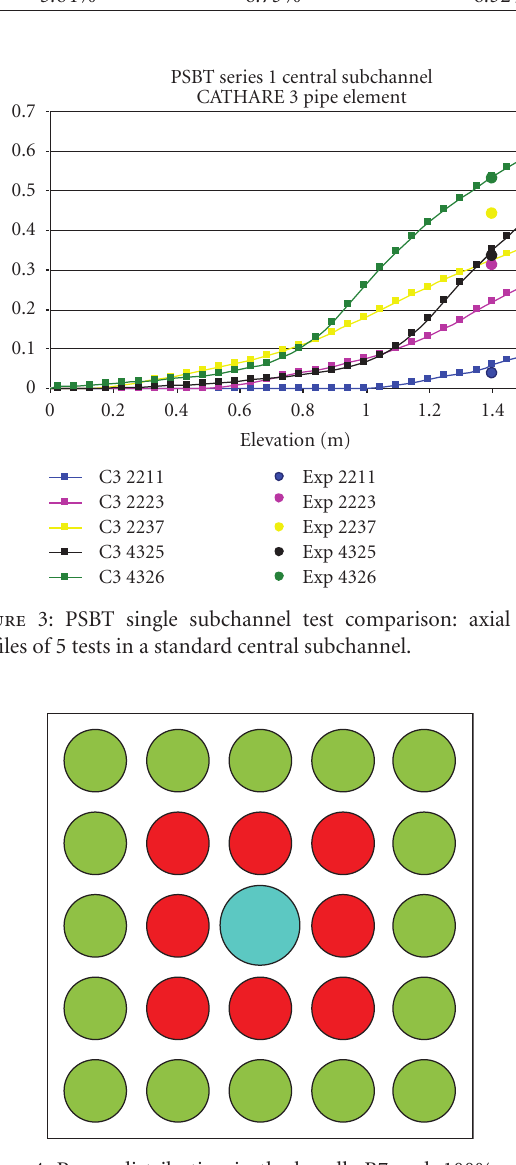
Figure 4: Power distribution in the bundle B7: red: 100%, green: 85%, blue: unheated